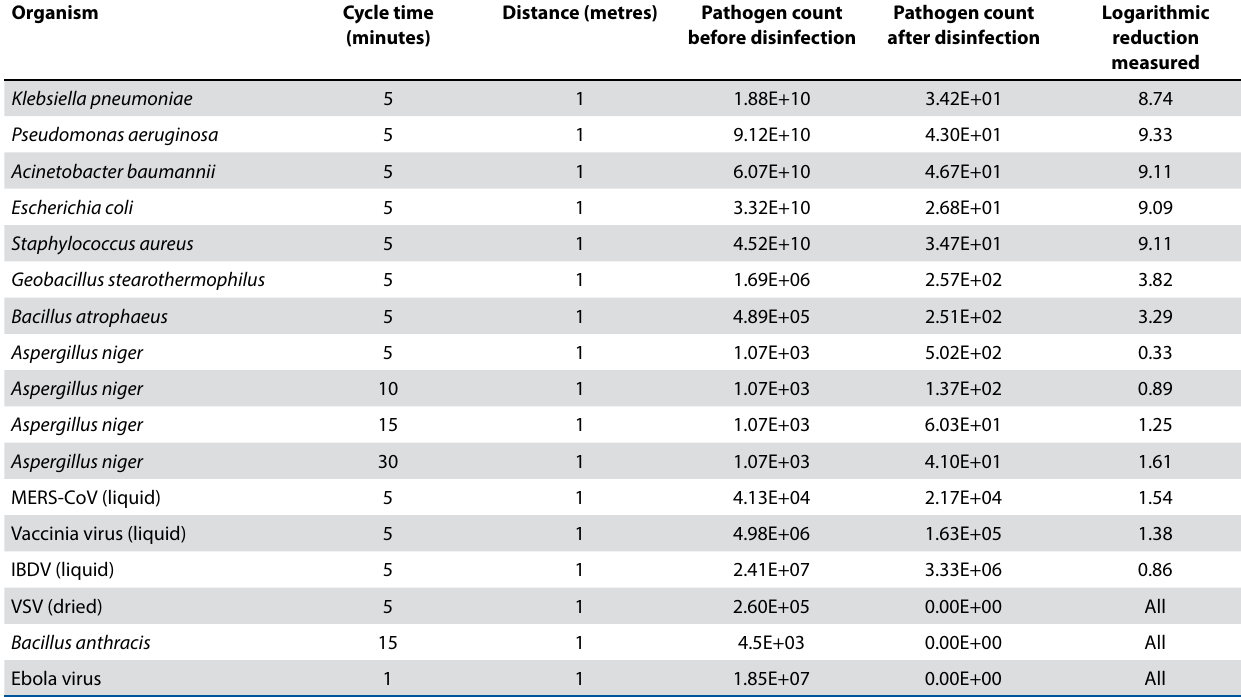
Table 1: Independent laboratory testing results, involving pulsed xenon ultraviolet